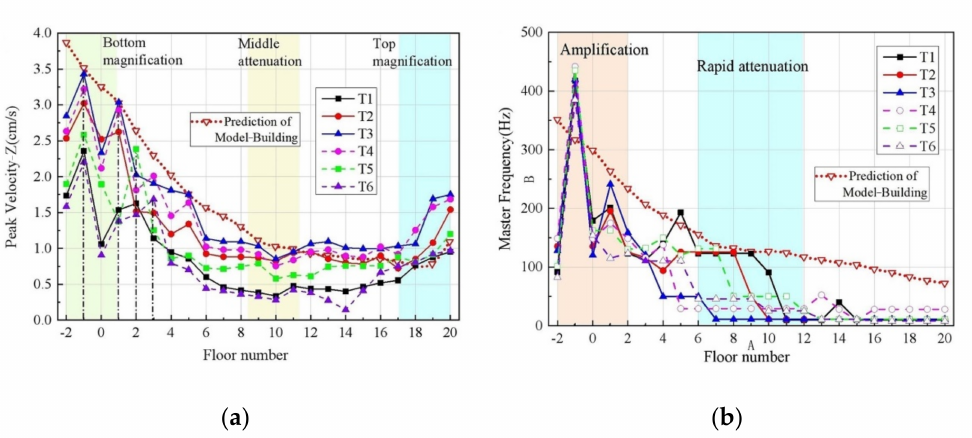
Figure 12. ( a ) The curve of the blasting vibration speed with time on a building. ( b ) Variation of the primary frequency of vertical vibration of blasting with